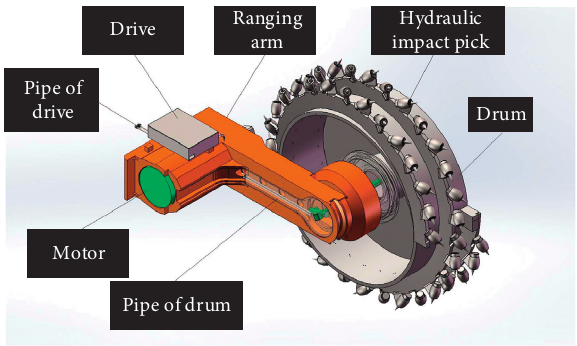
Figure 3: Structure of drum using impacting-cutting